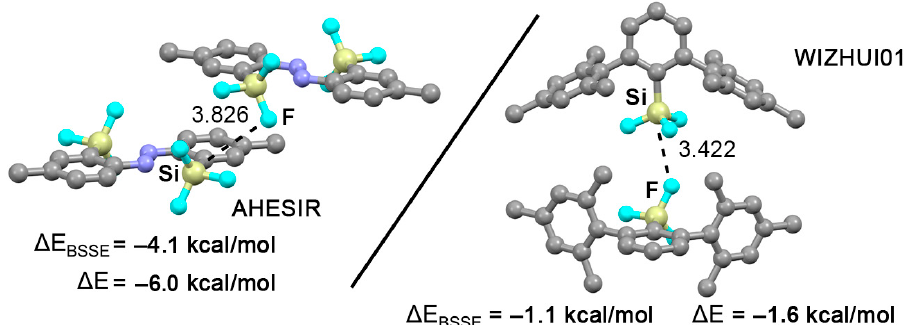
Figure 6. Partial views of the X-ray structures corresponding to AHESIR (left) and WIZHUI01 (middle). The tetrel bond distances are given in Å. The CSD codes are also indicated.